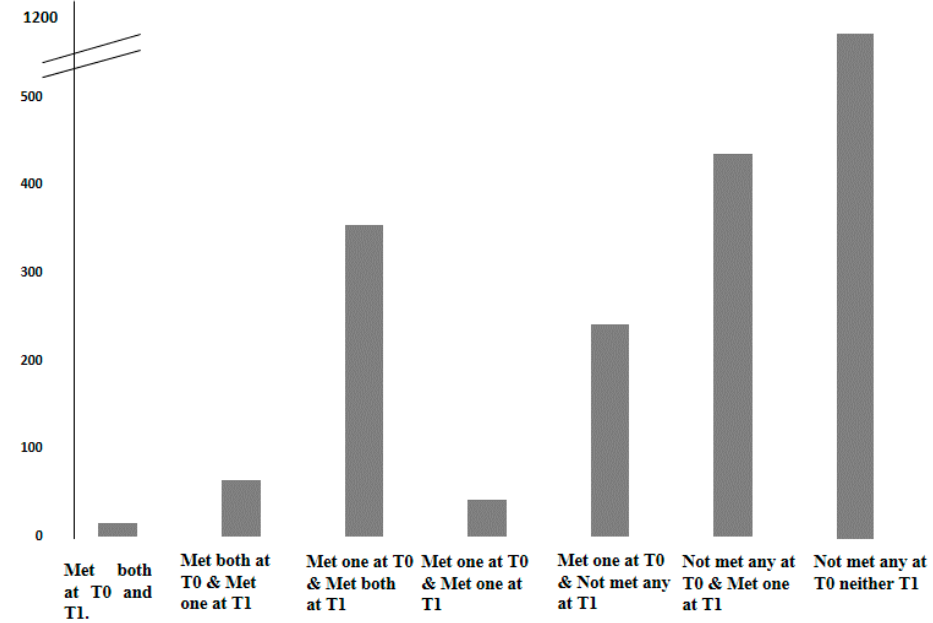
Figure 1. Proportion of European preschool children in each group. Groups are according to whether they met physical activity (PA) and/or screen time (ST) recommendations.